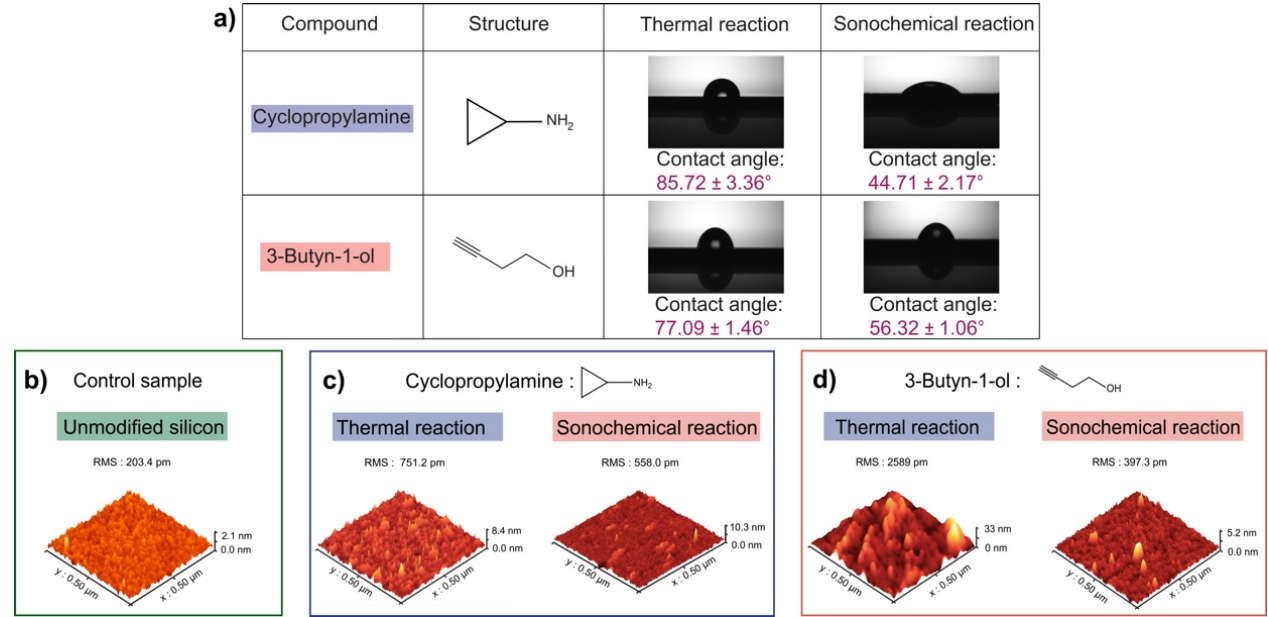
Figure 1. ( a ) Contact angle measurements of cyclopropylamine and 3-Butyn-1-ol after thermal and sonochemical reaction. ( b ) AFM examination of the control sample. ( c ) The AFM characterization of cyclopropylamine showed a roughness value of 751.2 pm for the thermal sample and 558 pm for the sonochemical sample. ( d ) AFM images of 3-Butyn-1-ol after thermal and sonochemical reaction.